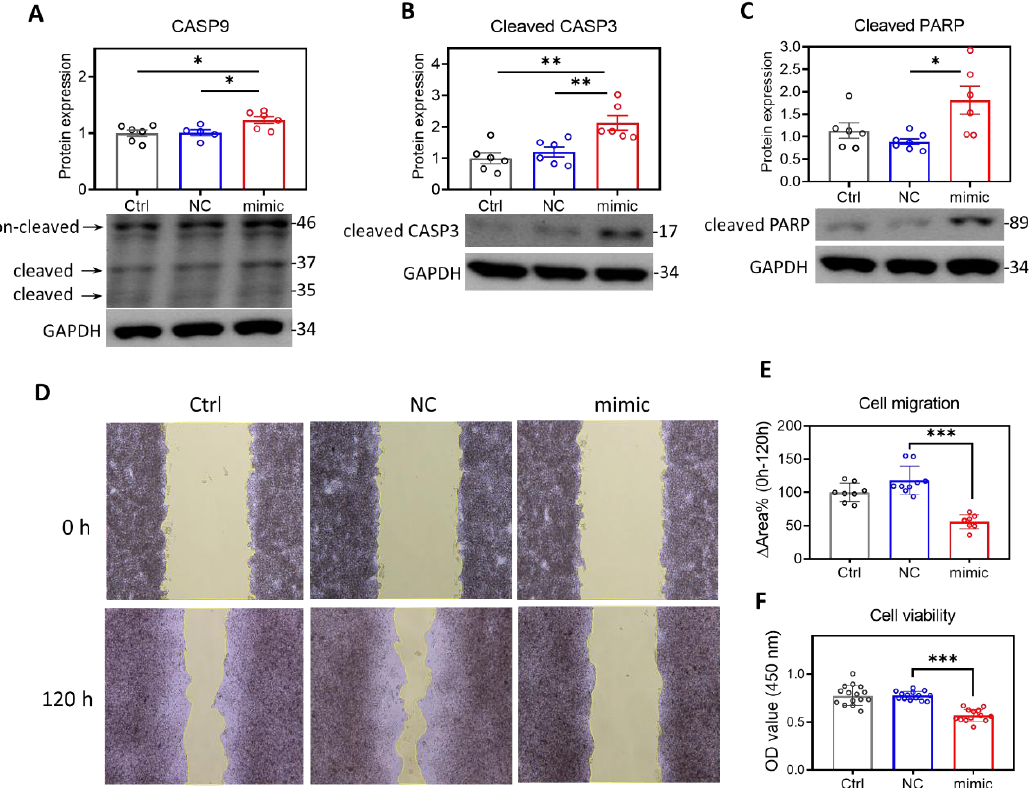
Figure 6. Overexpression of MIR29A -3p in HepG2 cells might induce apoptosis signaling and inhibits wound healing performance, and viability. HepG2 cells treated with transfection reagent as a control (Ctrl), MIRs negative sequence (NC), or MIR29A -3p mimic (mimic) for 24 h, followed by further assays. The activity of apoptosis signaling was examined by probing the cleaved (37 and 35 kDa)/non-cleaved (46 kDa) caspase-9 (CASP9) ( A ), cleaved caspase-3 (CASP3) ( B ), and cleaved poly (ADP-ribose) polymerase (PARP) ( C ). GAPDH as loading control. The ratio of cleaved/non-cleaved CASP9, and the GAPDH-normalized cleaved CASP3 and cleaved PARP were analyzed for the densitometric quantification. ( D ) Representative image at 0 h and 120 h of wound healing assay. ( E ) Quantification histogram of the changed area percentage ( ∆ Area%) of the scratched ditch determined by the migrated cells. ( F ) Cell viability detected by WST-1-based OD450 signal. * p < 0.05, ** p < 0.01, *** p < 0.001 between indicated groups.